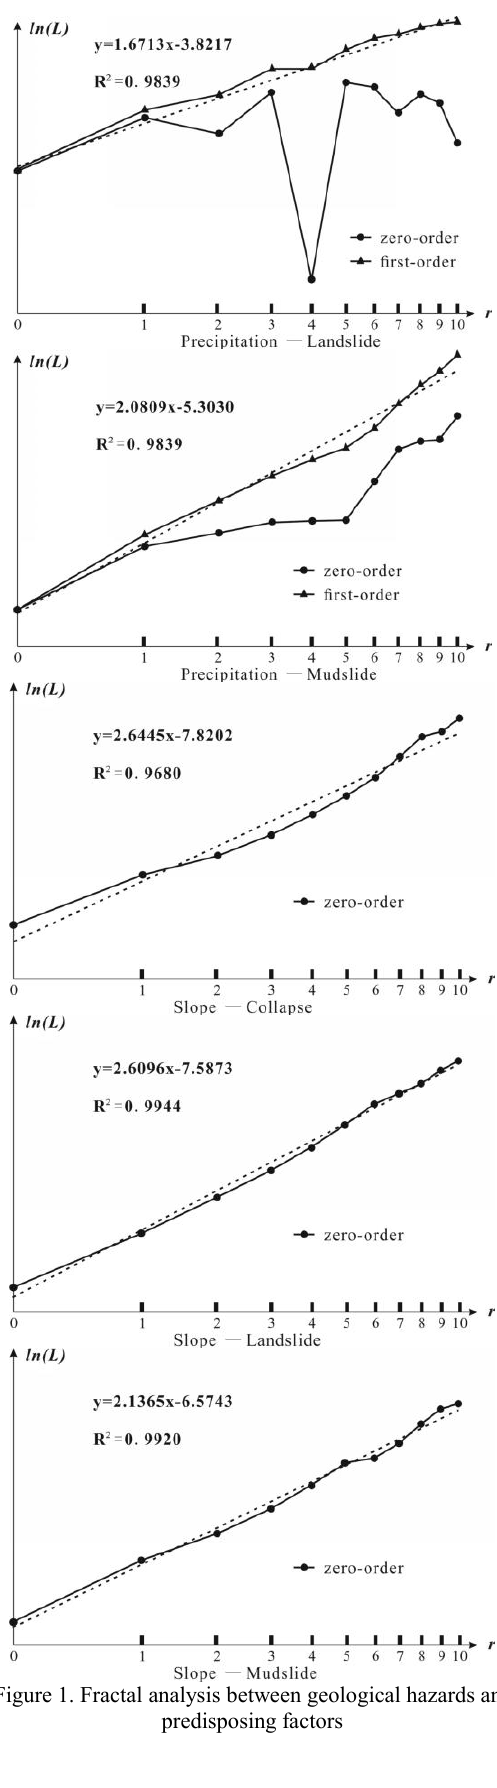
Figure 1. Fractal analysis between geological hazards and predisposing